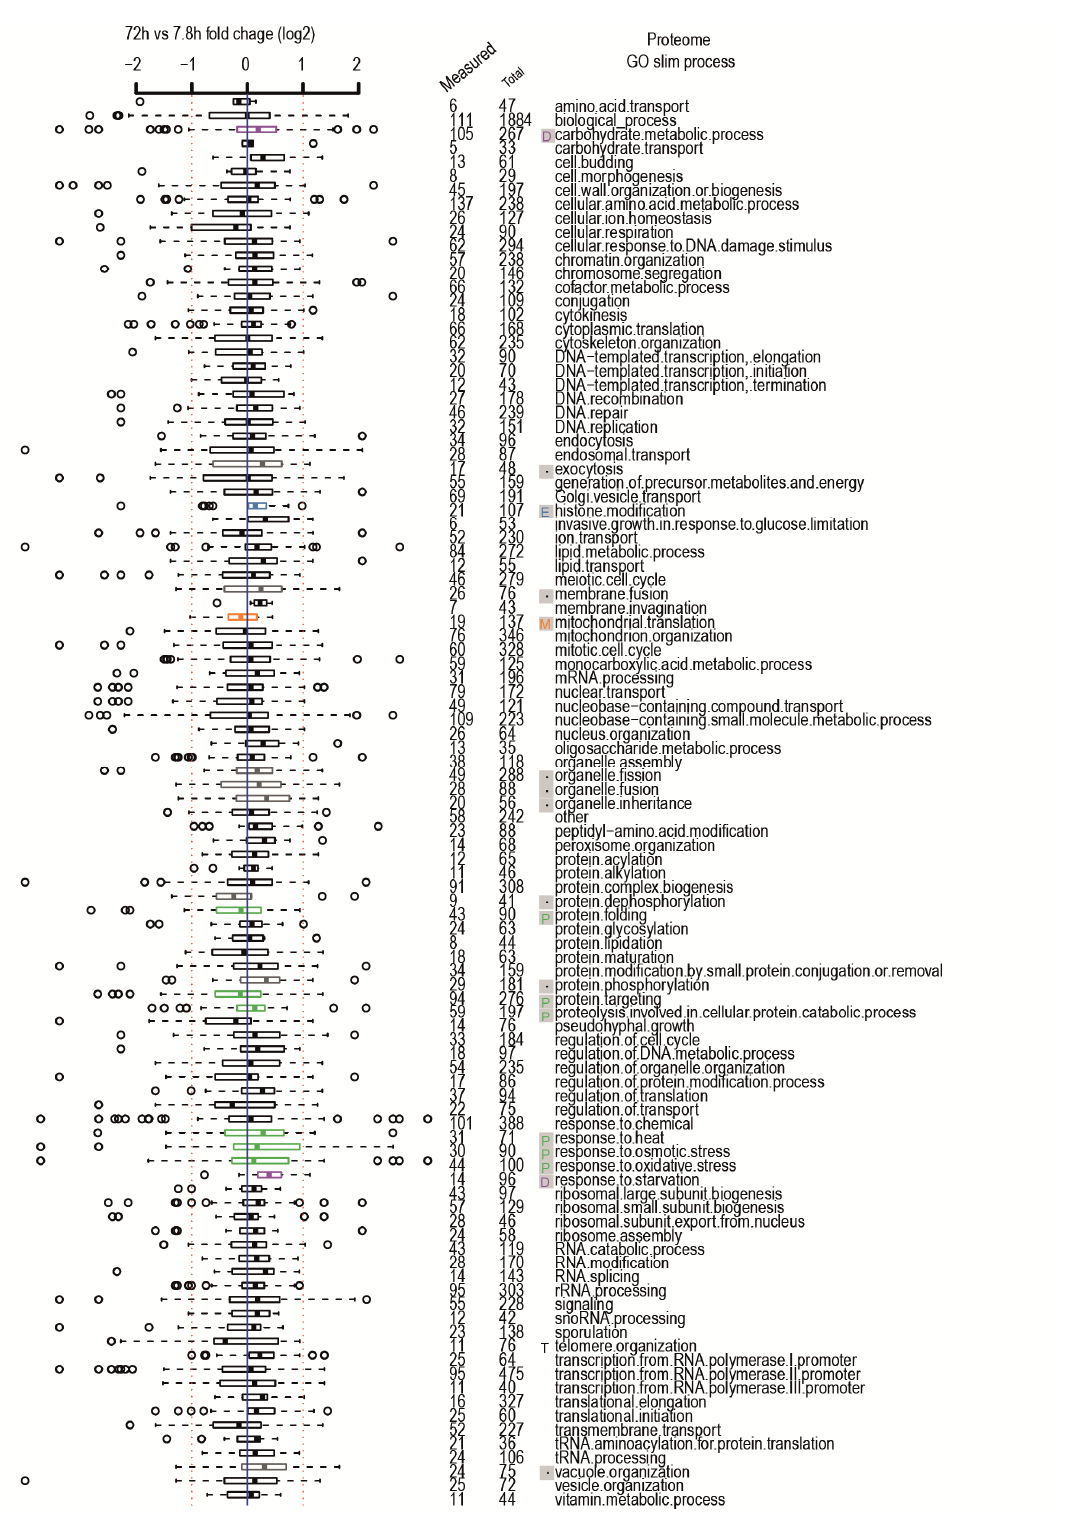
FIGURE 2: Age-related changes in Gene Ontology Processes. Gene ontology process categories taken from GO Slim lists of yeastgenome.org. Rele- vant Hallmarks of Aging are listed next to terms, as discussed in the text, same legend as Figure 1. Plot is comparison of old (~72 hours of aging with roughly 42% viability of the population) versus young (~8 hours of aging with nearly 100% viability of the population) protein-level changes from the [7] dataset. Data expressed in terms of fold change on a log2 scale. Red dashed line indicates two fold change. Blue solid line zero change. Numbers of proteins measured per GO term are listed out of total proteins in category. Distributions of fold changes per GO term expressed as horizontal box- and-whisker plots. The thick black line within the box is the median of the data, the box extends to the upper and lower quartile of the dataset (i.e. to include 25% of the data above and below the median, respectively), whiskers (dashed lines) represent up to 1.5 times the upper or lower quartiles and circles represent